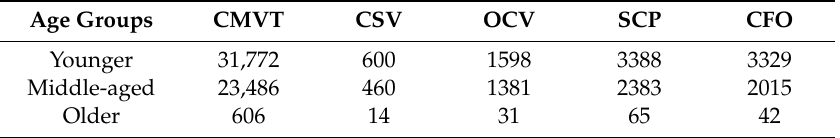
Figure 1. Age distribution in the five examined crash types. Y: younger, M: middle-aged, O: older. ( a ) CMVT: crashes with motor vehicles in transport, ( b ) CSV: crashes with stopped vehicles, ( c ) OCV: other crashes between vehicles (e.g., crashes between motor vehicles and nonmotor vehicles), ( d ) SCP: sideswipe crashes with pedestrians, ( e ) CFO: crashes with fixed objects. Table 2. The number of drivers in each age group for each crash